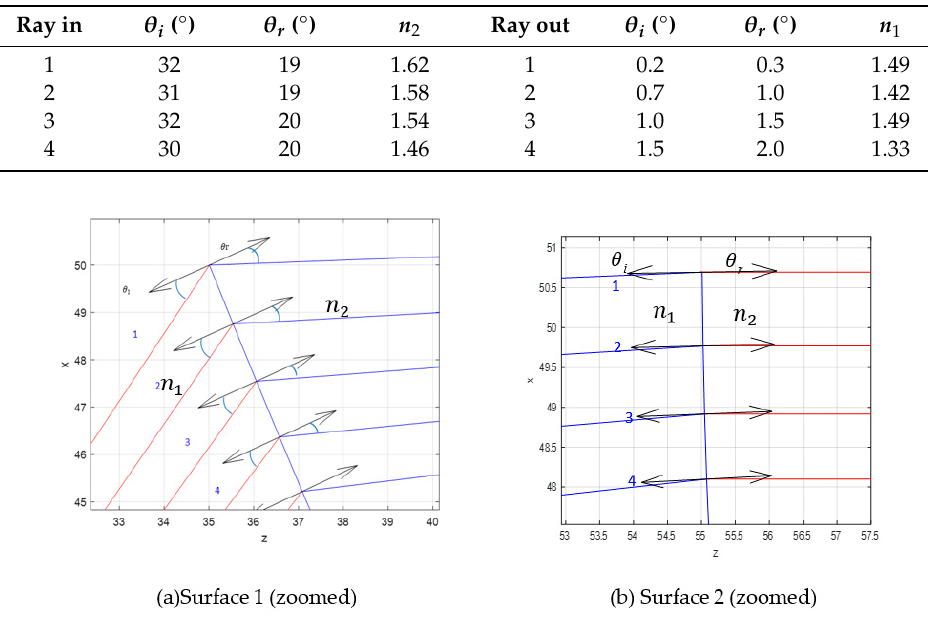
Table 3. Calculated n -value.